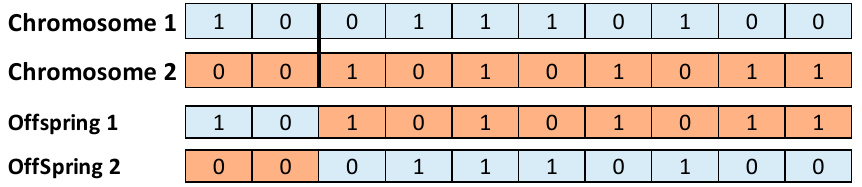
Figure 1. A sample single-point crossover, with the point’s index set randomly to two. Mutation. See Figure 2. Following the new generation of crossover chromosomes, ran- dom changes in the selected features of one chromosome are made by the mutation process. process flipped the value of some genes’ bits, for a random number of chromosomes that have been reproduced using the aforementioned crossover process. Figure 2. Mutation example with 4 genes to be mutated (genes at index 3, 5, 7, and 10).